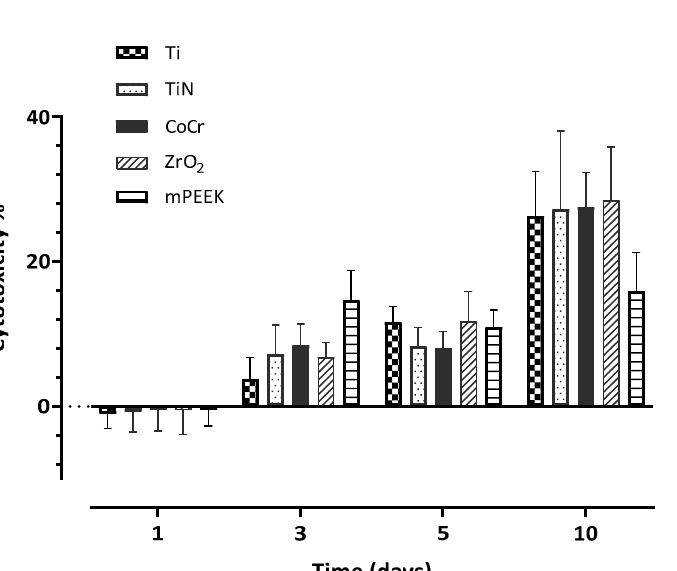
Table 5. The mean and standard deviation values of HGFB cell cytotoxicity percentage at days 1, 3, 5, and 10. Means with the same letters are not statistically different ( p > 0.05).